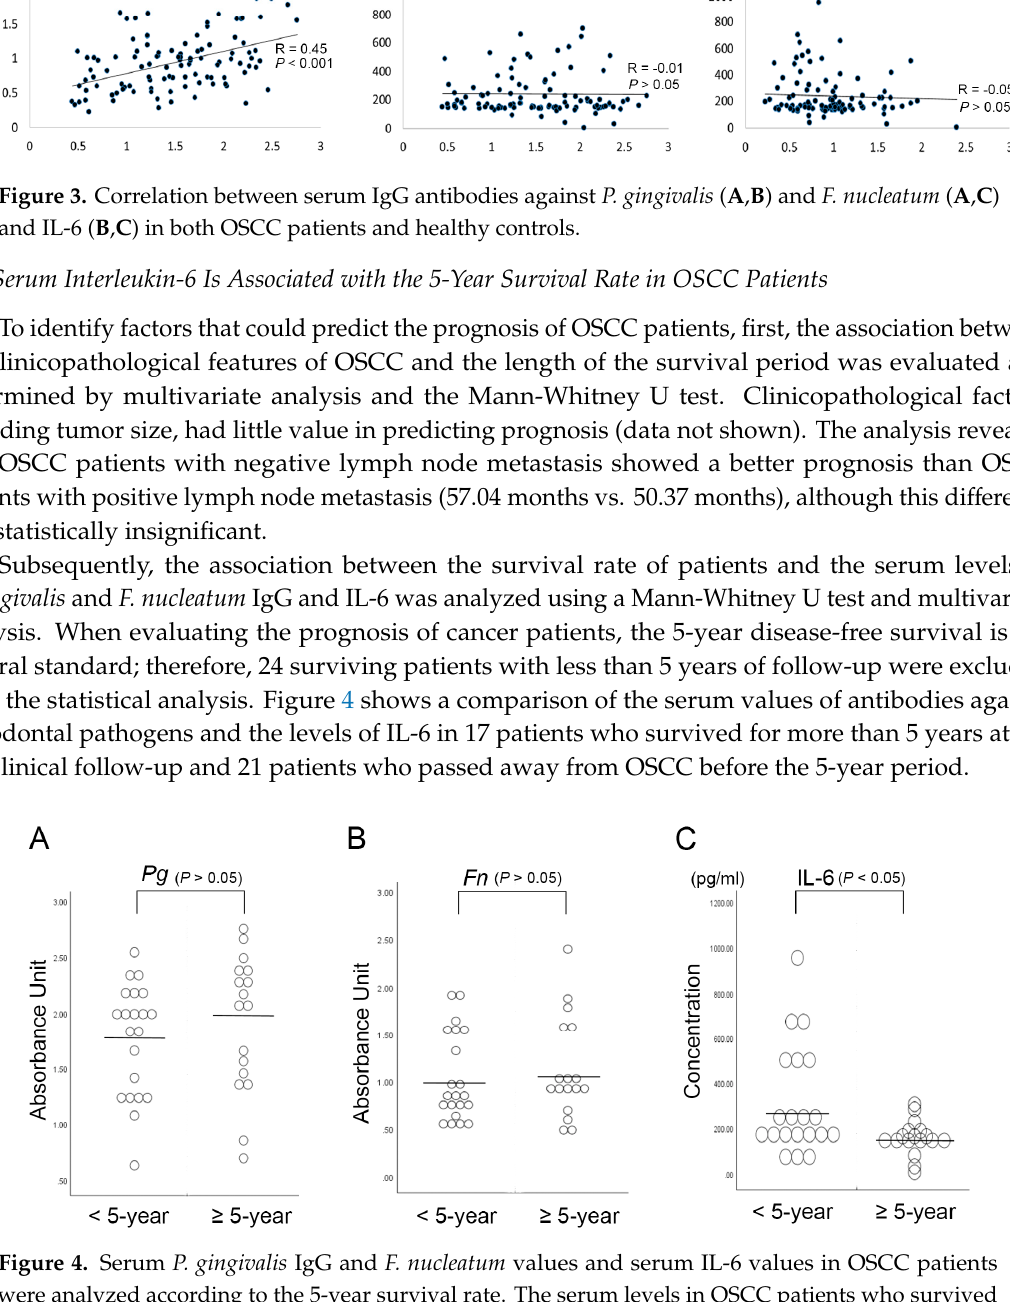
Figure 2. Receiver operating characteristic (ROC) curves ( A ) used for the diagnosis of OSCC patients vs healthy controls ( A ). The AUCs (areas under the ROC curves) are 0.708 for P. gingivalis IgG, 0.543